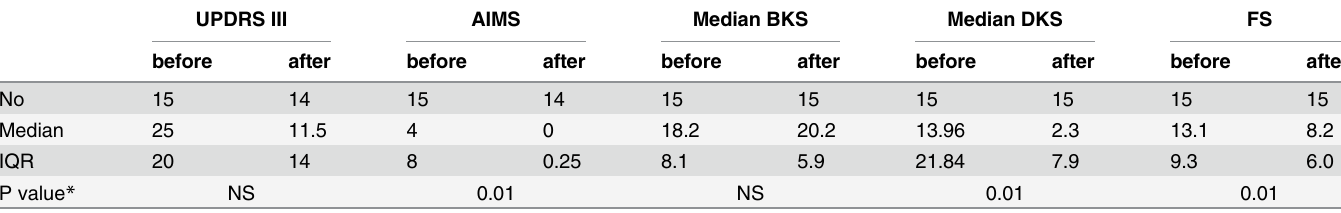
Table 1. Scores from ratings scales and PKG before and after insertion of Deep Brain